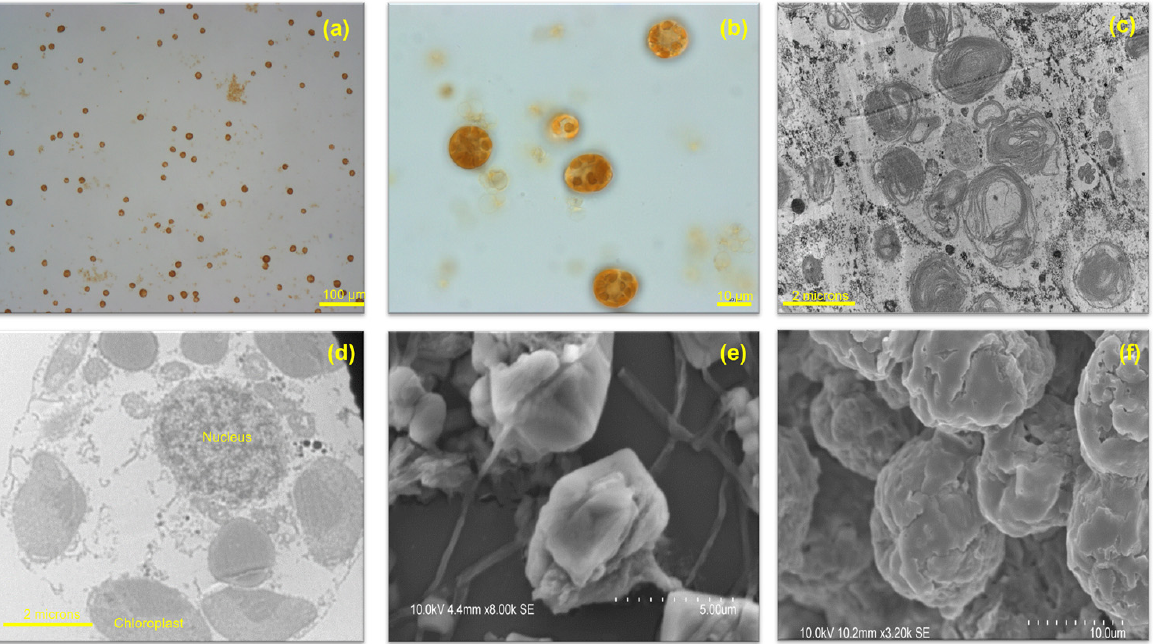
Figure 2. Light microscopy ( a , b ), transmission electron micrograph (TEM) ( c , d ) and scanning electron micrograph (SEM) ( e , f ) of H. akashiwo . The images were taken by Zeiss Imager Z1 Upright, Philips 420 Transmission Microscope, and Philips CM10 Transmission Microscope, respectively.